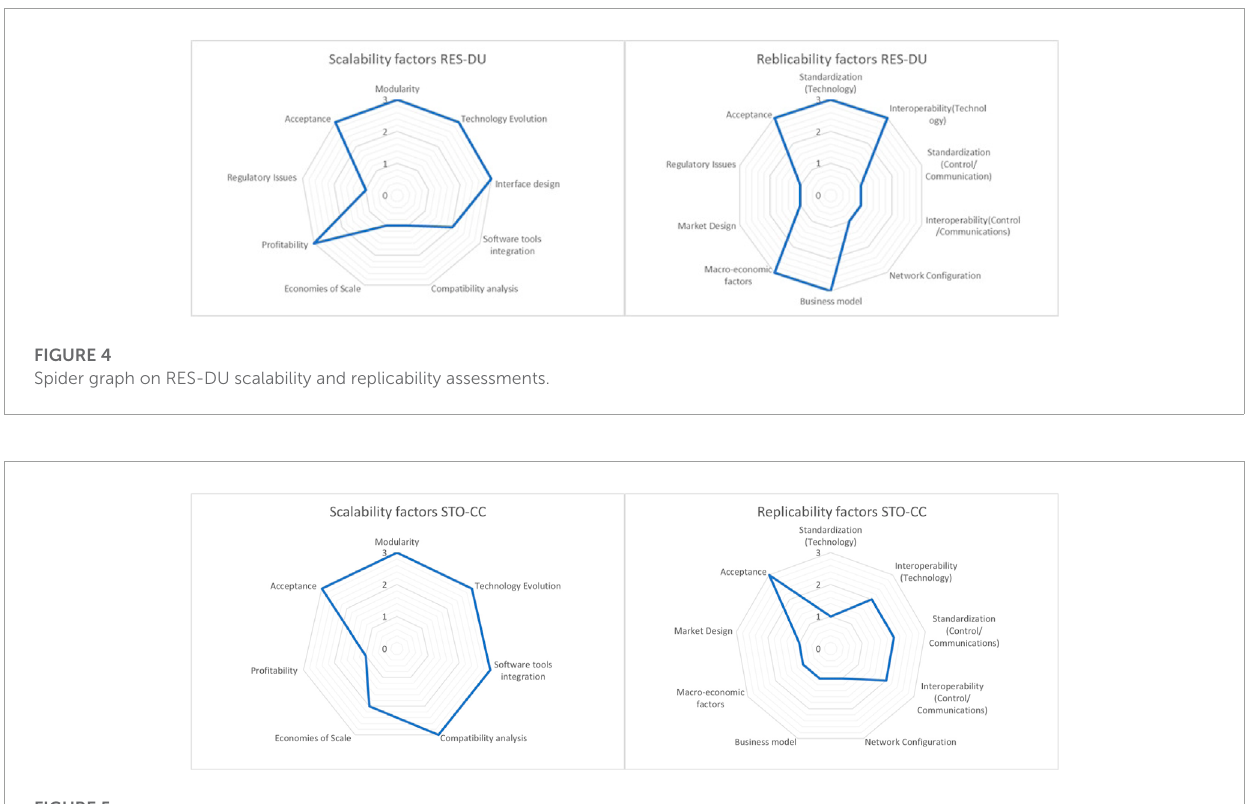
FIGURE 5 Spider graph on STO-CC scalability and replicability